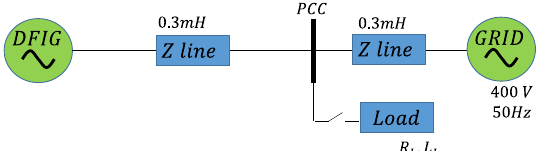
Figure 14. Single line diagram of the system implemented and used for testing.